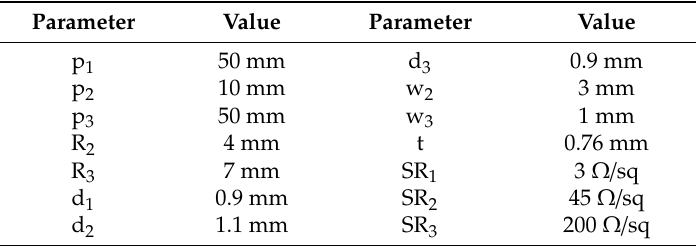
Table 1. The optimized structural parameters of the absorber.